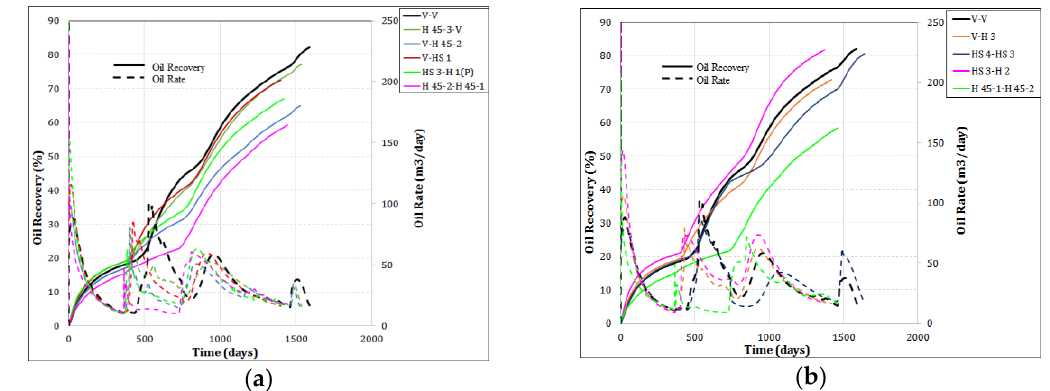
Figure 5. Oil production performance of several well combinations belonging to Category C: ( a ) H-V and V-H cases, V-HS, HS-H (P) and H 45-H 45 groups; ( b ) V-H case, HS-HS, HS-H